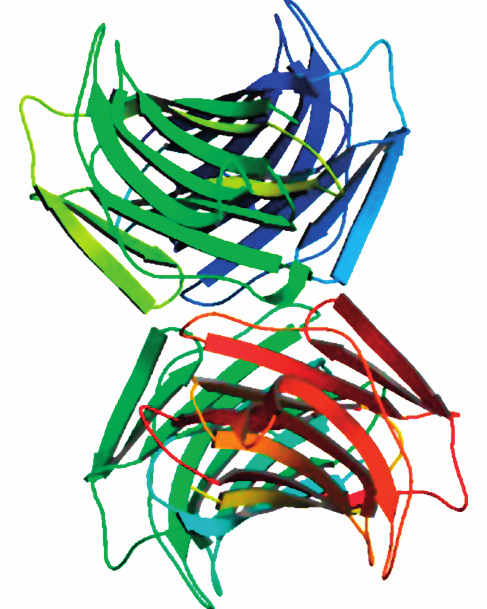
Figure 1. Tetrameric arrangement of Cinachyrella sp. galectin (CchG), the first three-dimensional structure of a lectin derived from a marine sponge (PDB Code: 4AGV,